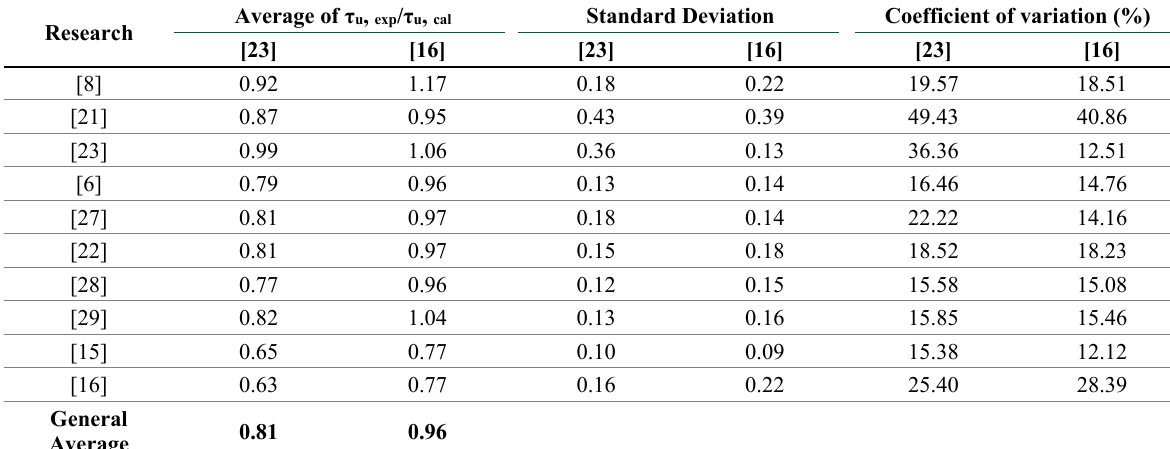
Table 5. Comparison of statistical parameters obtained according to the equations of Mansur et al. [23] and Soares